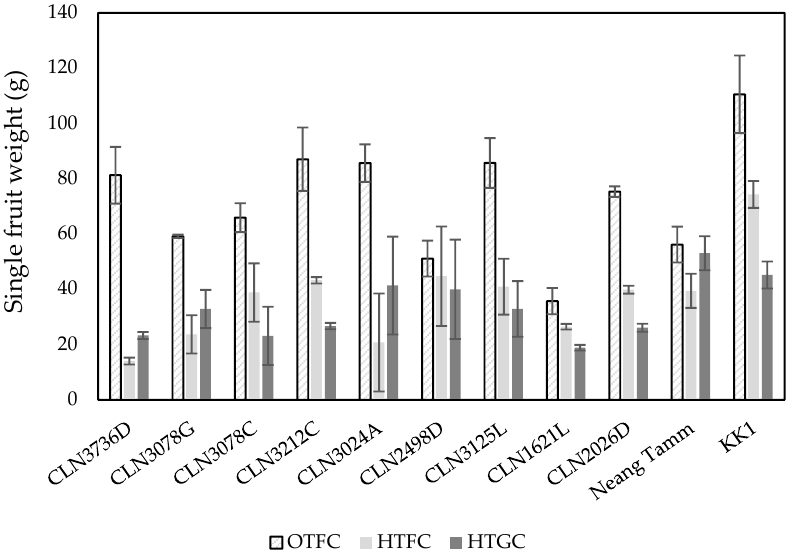
Figure 1. Single fruit weight of tomato genotypes under optimal temperature field condition (OTFC), high temperature field condition (HTFC), and high temperature greenhouse condition (HTGC). Value is the mean of three replications with the error bars which represent standard deviation.